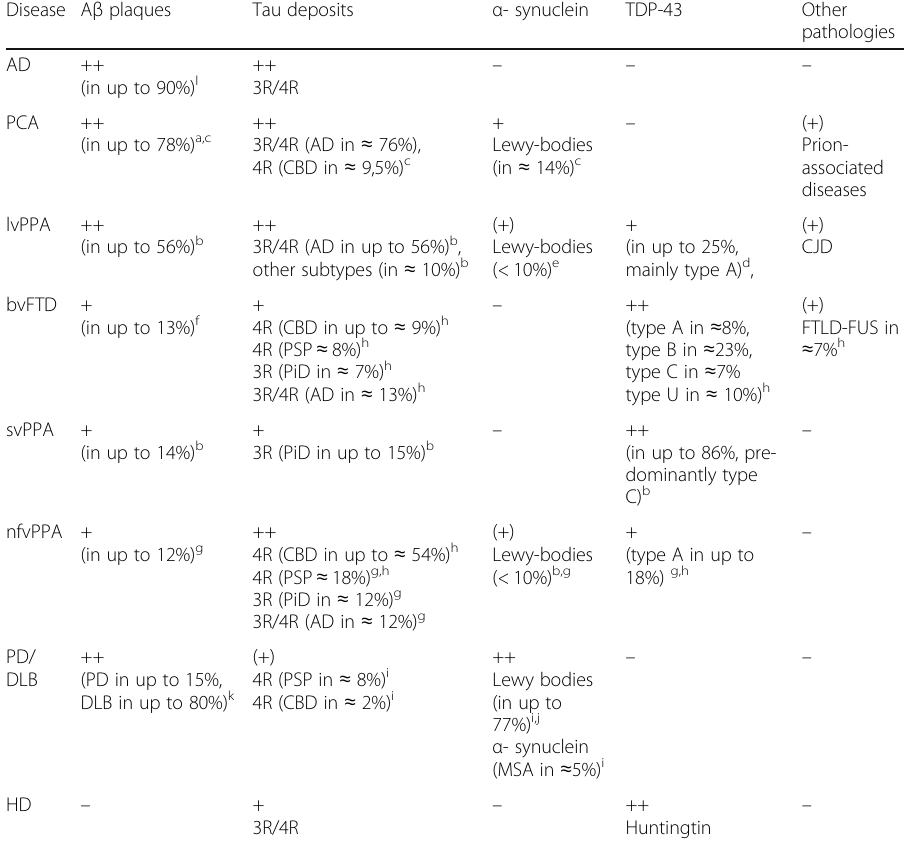
Table 1 Summary of histopathological findings of the different neurodegenerative syndromes Disease A β